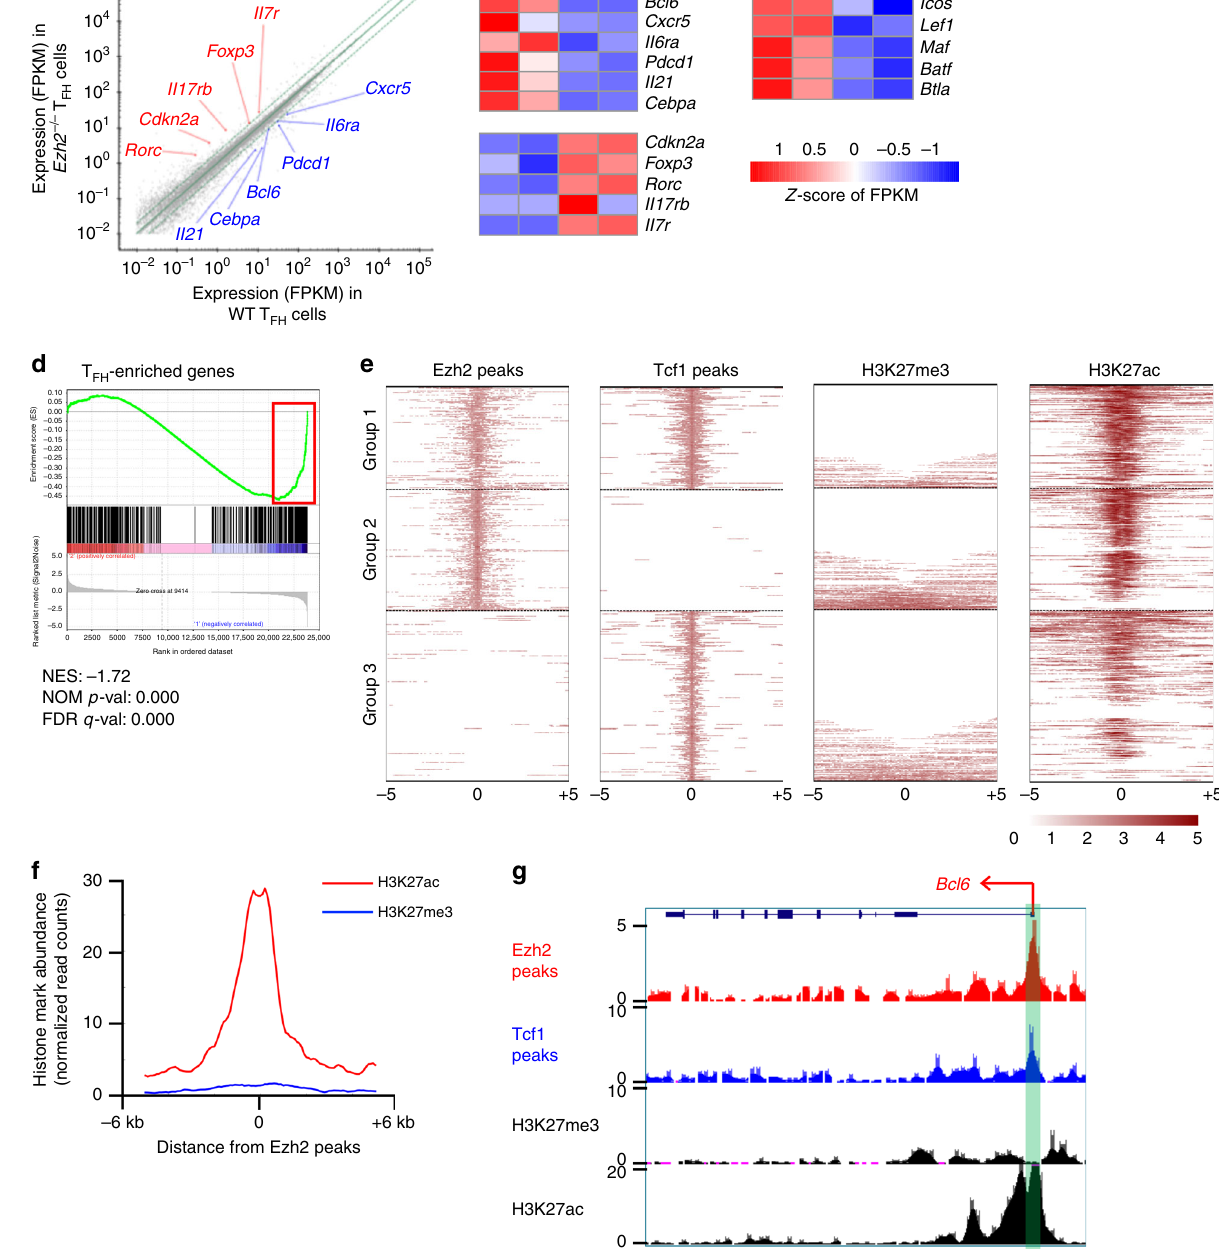
Fig. 2 Ezh2 activates the T FH transcriptional program. a RNA-Seq analysis of Ezh2 – / – or WT CXCR5 + PD-1 lo T FH cells sort-puri fi ed on day 8 after VacV infection. Scatterplot shows the average FPKM values of two replicates of WT vs. Ezh2 – / – T FH cells, with green lines denoting gene expression changes by a factor of 2. Select differentially expressed genes are marked, with genes upregulated in Ezh2 – / – T FH cells in red and those downregulated ones in blue. b – c Heatmaps of select differentially expressed genes with ≥ 2 fold ( b ), or <2 fold but ≥ 1.5-fold expression changes ( c ), all with an FDR < 0.05. ( d ) GSEA enrichment plot shows T FH -associated gene set (from Choi et al. 7 ) is negatively enriched in Ezh2 – / – T FH cells. NES, normalized enrichment scores, NOM p - val, nominal p values, FDR q-val, false discovery rate q values. Heatmap of the negatively enriched genes at the leading edge (highlighted in red rectangle) is shown in Supplementary Figure 2a. e Heatmaps of Ezh2, Tcf1, H3K27me3, and H3K27ac ChIP-Seq signals, at + / – 5 kb around the Ezh2 peak summit (for Ezh2 and Tcf1 co-occupied sites in group1, and for Ezh2 solo sites in group 2) or Tcf1 peak summit (for the Tcf1 solo sites in group 3) in WT T FH cells. WT C57BL/6 mice were infected with VacV, and on 8 dpi, CXCR5 + PD-1 lo T FH cells were sorted from the spleens and analyzed by ChIP-Seq. In each group, the Ezh2 and Tcf1 common or solo peaks were clustered according to H3K27me3 signals (from low to high), and the H3K27me3 – peaks were further clustered according to H3K27ac signals (from high to low). The color scale indicates average signals using a 100-base pair window. f The pro fi le of H3K27me3 and H3K27ac at 51 Ezh2 peaks found within + / – 10 kb regions fl anking the TSSs of 47 genes identi fi ed at the leading edge of GSEA enrichment plot in ( d ). g ChIP-Seq tracks of Ezh2, Tcf1, H3K27me3, and H3K27ac at the Bcl6 gene locus as displayed on the UCSC Genome Browser, with the vertical